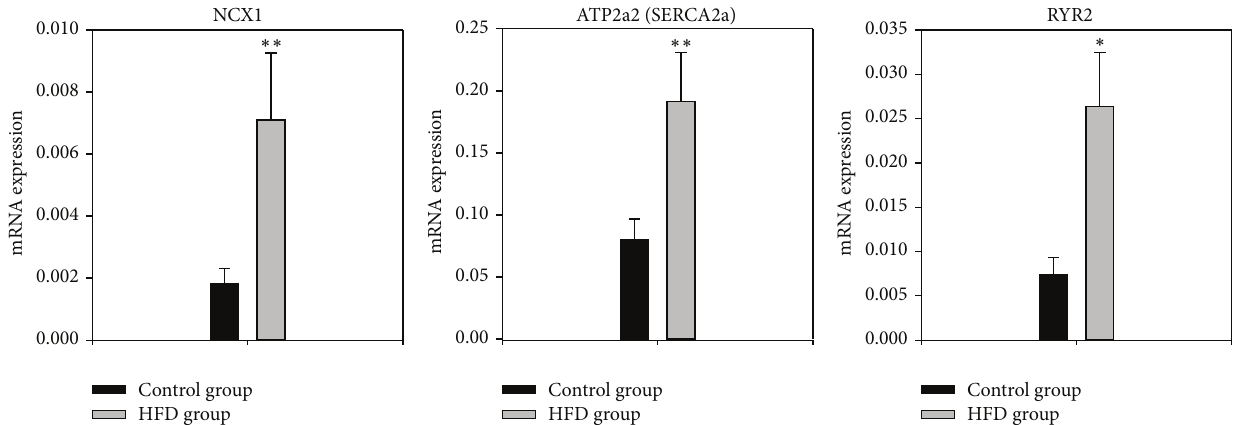
Figure 3: Normalised to 18-s expression of mRNA for major Ca 2+ -handling molecules in the left ventricle of the control and obesity groups in arbitrary units referenced to the housekeeper gene 18-s. Means ± SEM shown ( 𝑛 = 8 /group). ∗ Significantly different from the control group ( 𝑃 < 0.05 ). ∗∗ Significantly different from the control group ( 𝑃 < 0.01